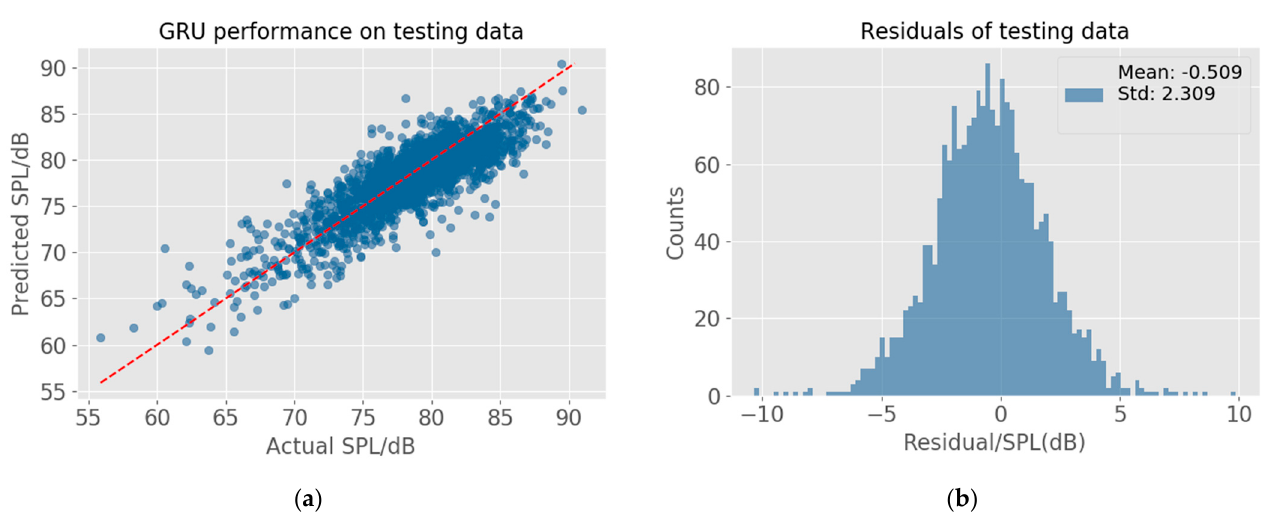
Figure 20. Final model performance and residual distribution (data from Mic 8): ( a ) comparison between predicted SPL values and actual SPL values based on testing data; ( b ) the distribution of residuals based on testing data.